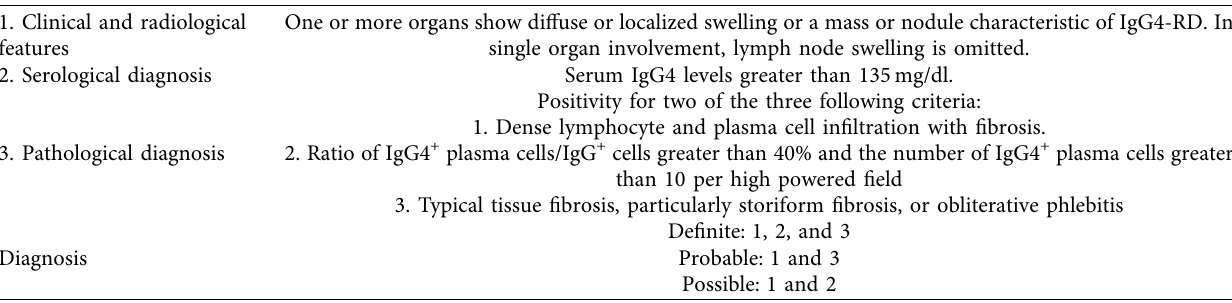
Table 1: The 2020 revised comprehensive diagnostic (RCD) criteria for IgG4-related disease (IgG4-RD) proposed by Umehara et al. [31]. 1. Clinical and radiological features